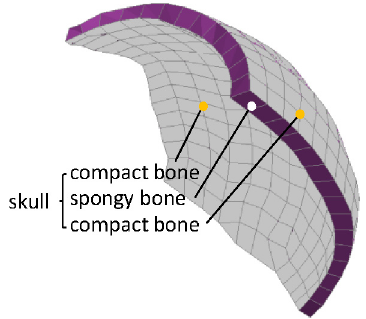
Figure 1. THUMS–head FE model. Figure 2. Three-layer structures of skull. Figure 2. Three-layer structures of skull.